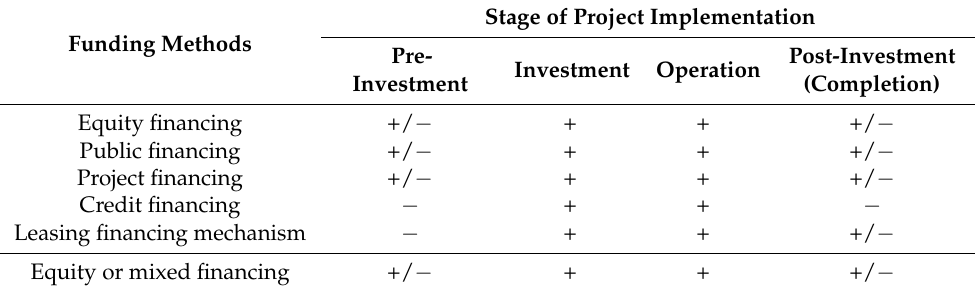
Table 4. Funding methods used in PPP projects at different stages of their